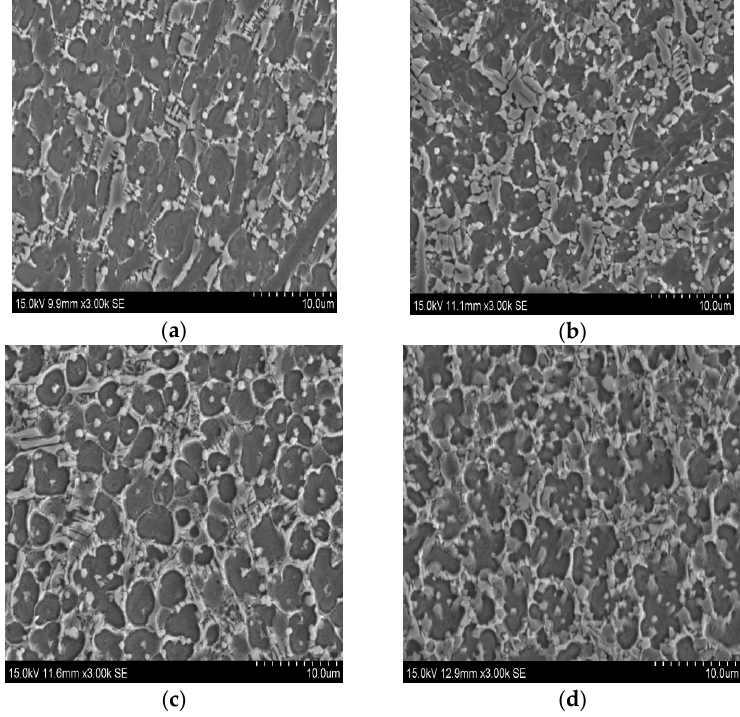
Figure 6. Microstructural characteristics of ( a ) coating 1; ( b ) coating 2; ( c ) coating 3; ( d ) coating 4.